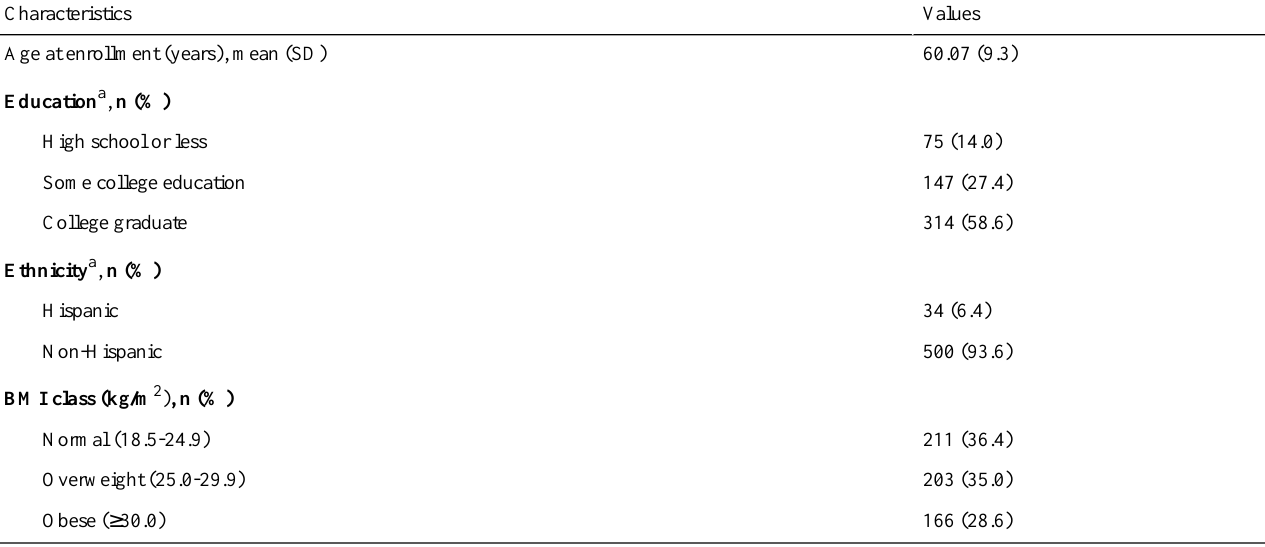
Table 2. Baseline characteristics for women who were enrolled in the Lifestyle Intervention for oVarian cancer Enhanced Survival accelerometer protocol at baseline (n=580).